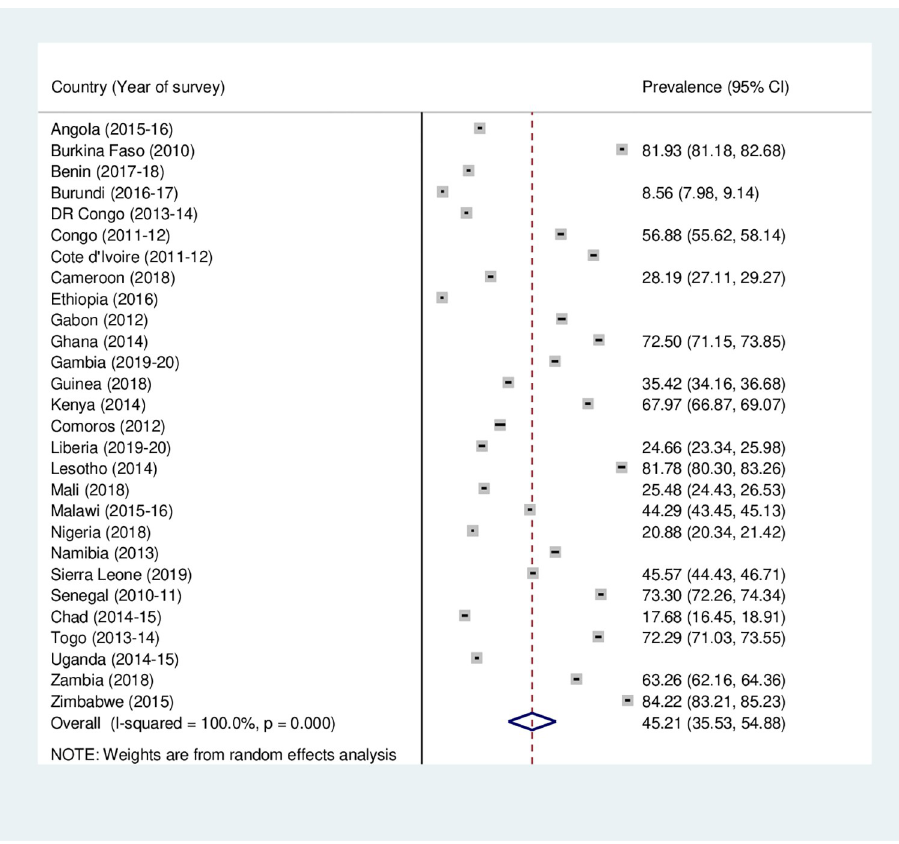
Fig 3. Forest plot showing the prevalence of postnatal care services utilization among women in sub-Saharan Africa.